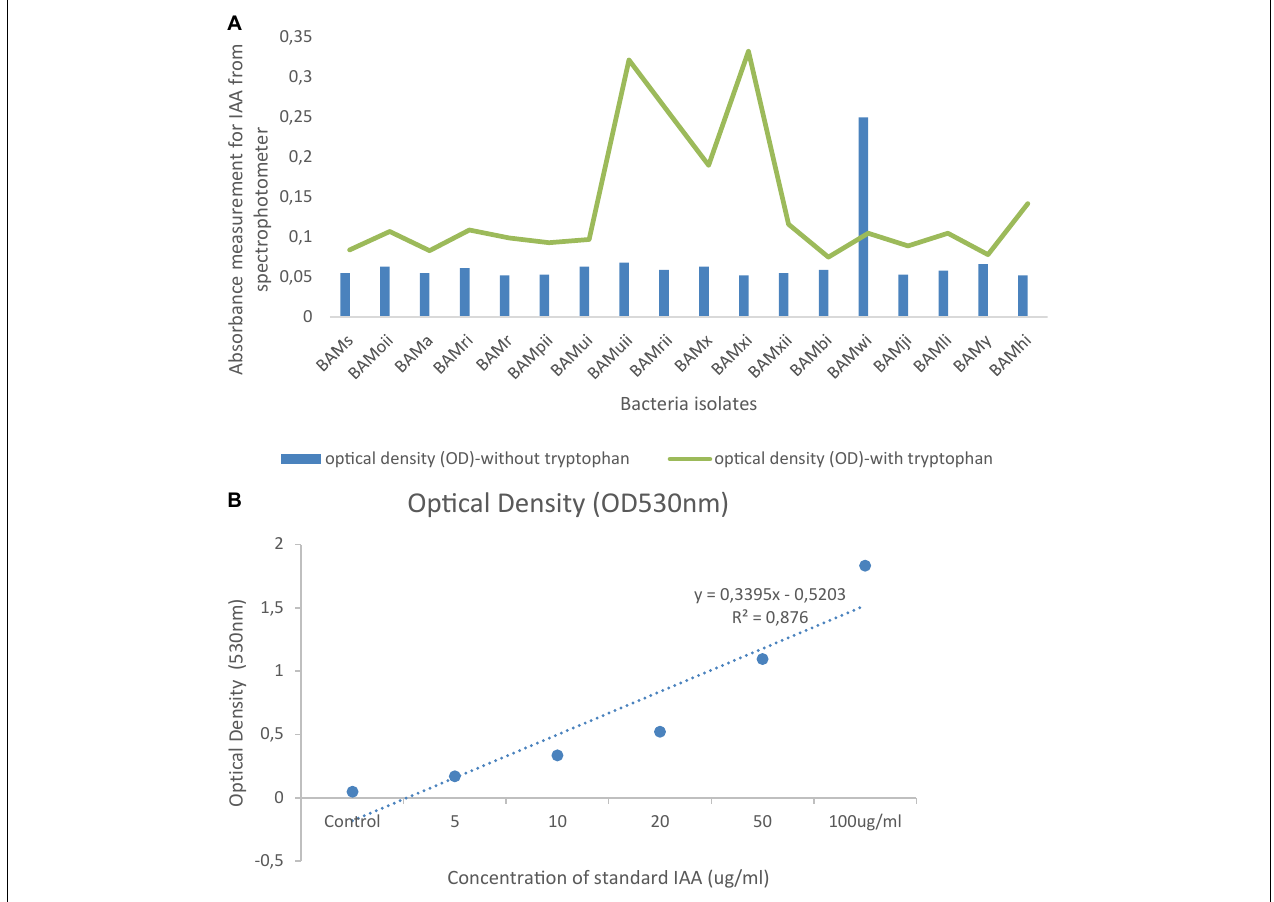
FIGURE 8 | (A) Spectrophotometric measurement of absorbance of IAA in isolates in the presence or absence of tryptophan at optical density of 530 nm. (B) A standard graph of IAA at optical density of 530 nm. TABLE 2 | Plant growth-promoting activities and biochemical activities of rhizobacteria isolates from the abovementioned soil samples. Isolates